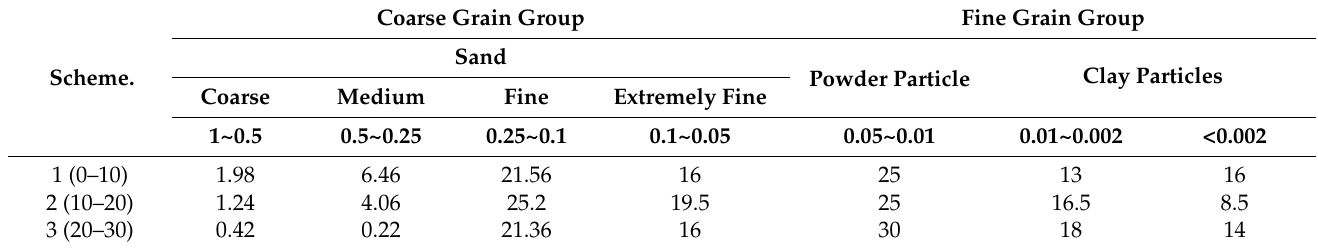
Table 4. Particle composition of the test soil samples.